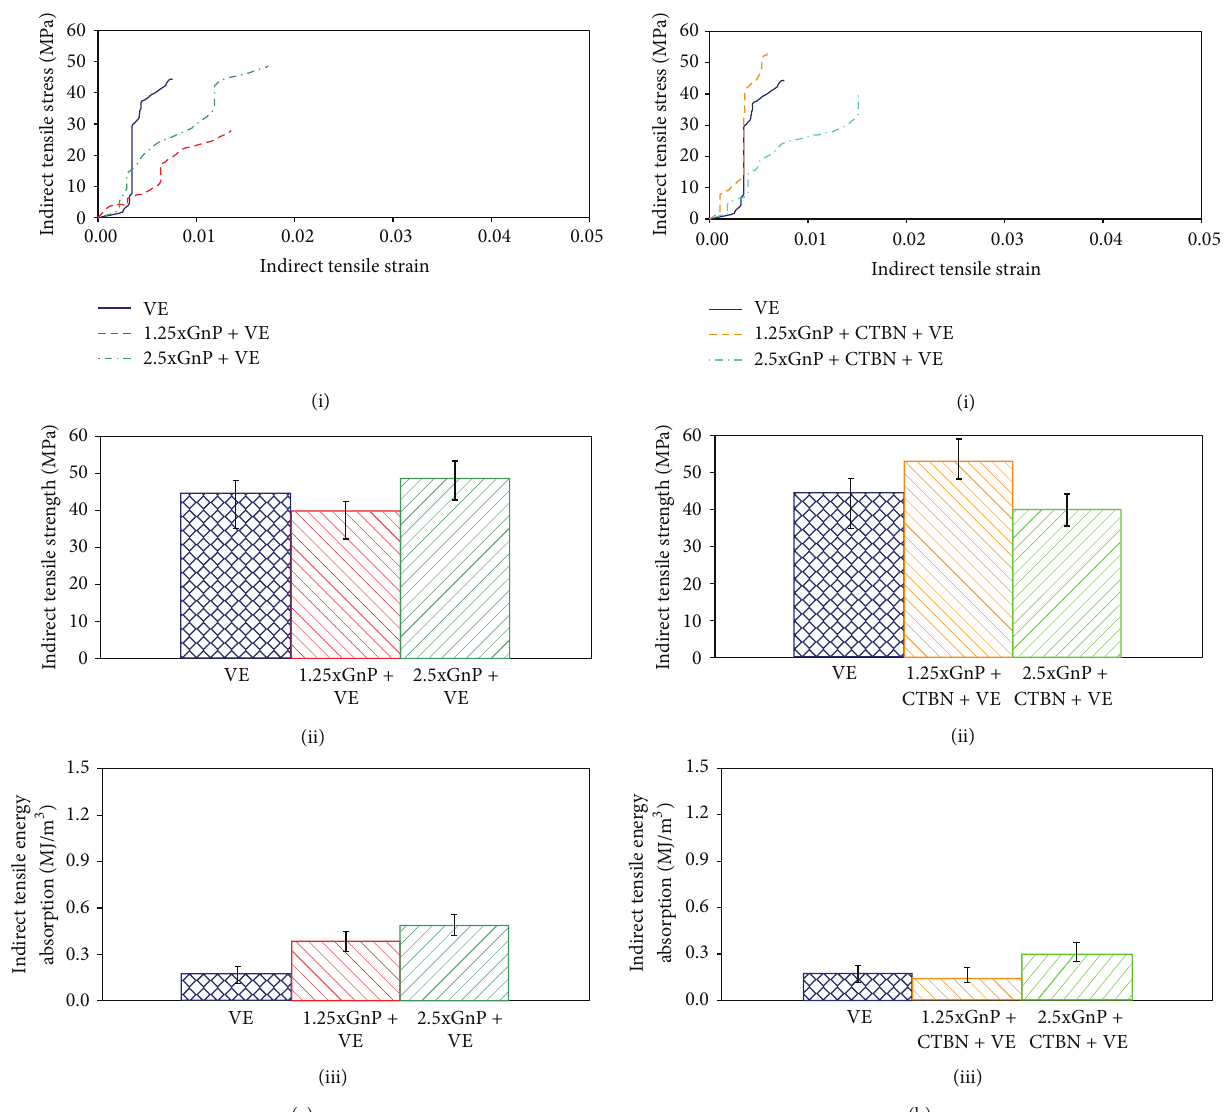
Figure 9: High-strain rate indirect tensile response from SHPB tests. (i) Typical stress versus strain behavior, (ii) strength, and (iii) energy absorbing capacity of (a) graphite platelet reinforced and (b) additionally CTBN toughened vinyl ester